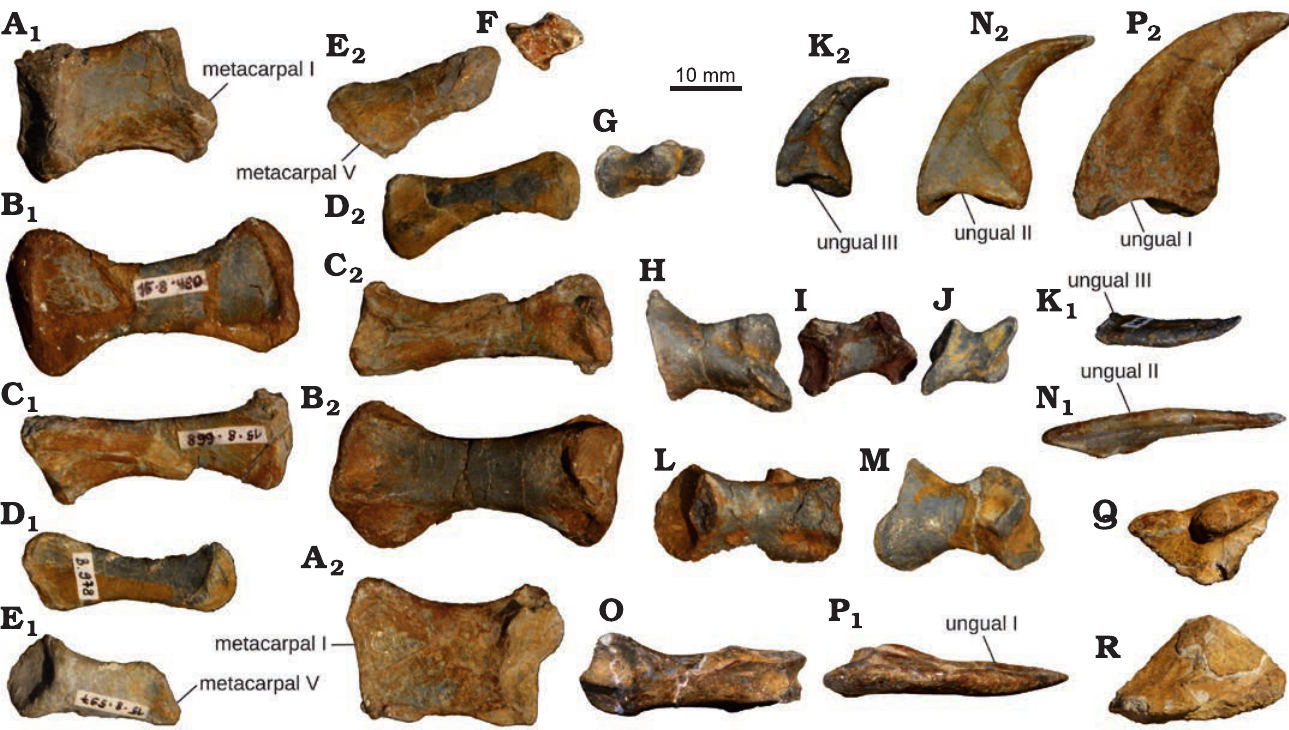
Fig. 9. Manus of juvenile Plateosaurus cf. trossingensis Fraas, 1913 skeleton MSF 15.8B. from the Norian of Frick, Switzerland. A . Left mc I (MSF 15.8.2032). B . Left mc II (MSF 15.8.480). C . Left mc IIII (MSF 15.8.668). D. Left mc IV (MSF 15.8.2033). E . Left mc V (MSF 15.8.597). In